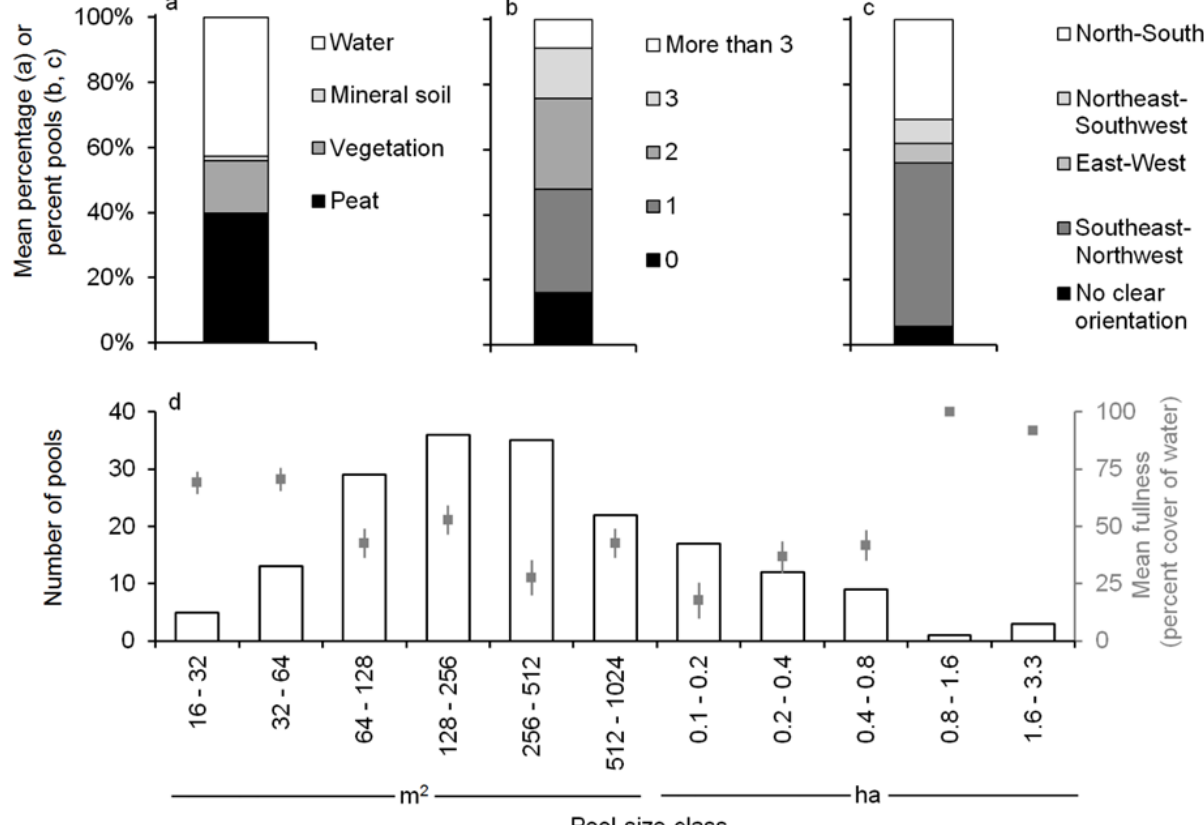
Figure 6. Pool characteristics in the five studied pool complexes: (a) cover of potential pool surface area (2005 field survey); (b) number of channels connecting with other pools (2005 field survey); (c) pool orientation; (d) pool size frequency distribution (white bars) (note that the x -axis is on a log secondary axis shows mean fullness (percent cover of water, 2005) by pool size class (grey squares, with standard